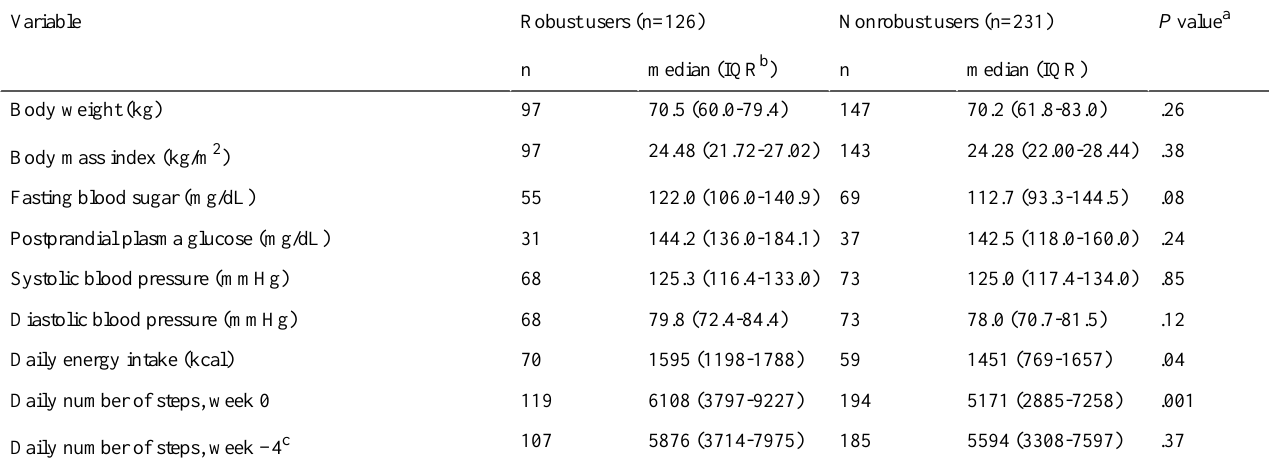
Table 4. Comparison of measured data at week 0 between robust and nonrobust